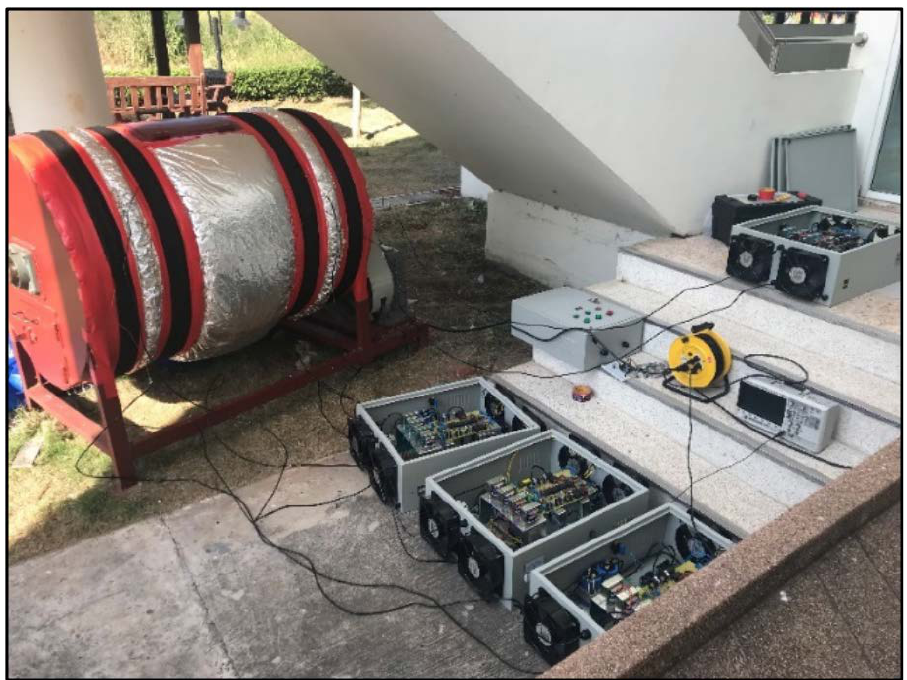
Figure 12. A heater with a total of 4 sets of bioreactors applied simultaneously with a set of copper wire.